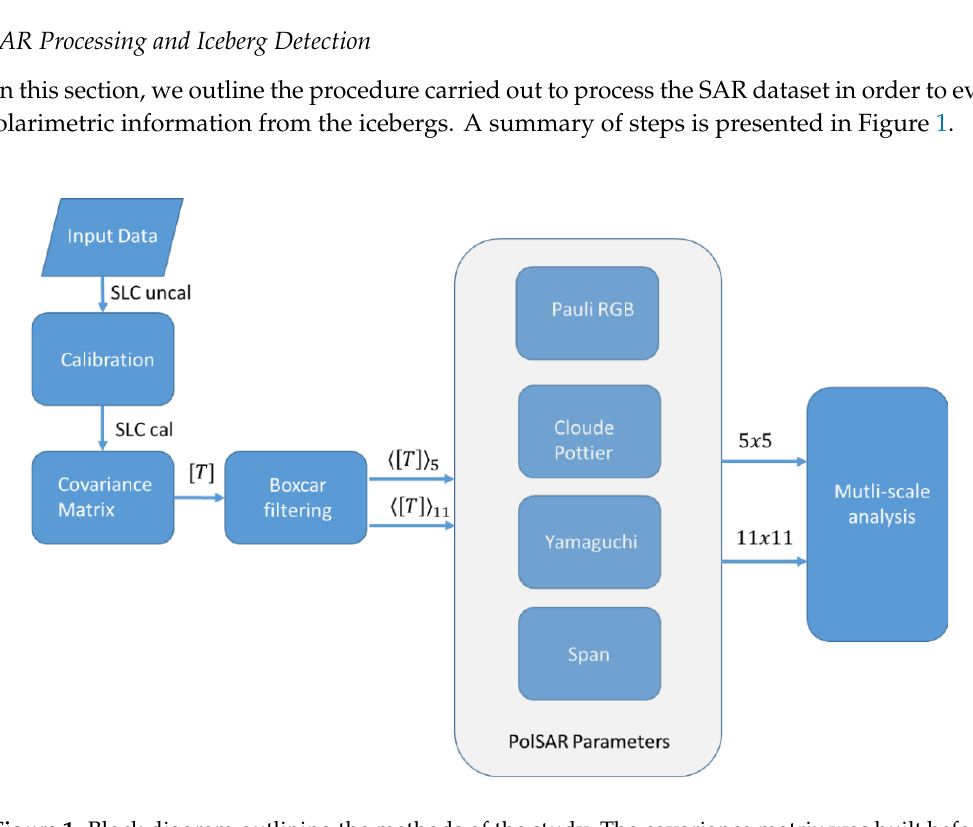
Table 1. ALOS-2/PALSAR-2 JAXA properties. Centre DMS coordinates are selected for latitude and longitude. Incidence angle range is min, centre and max. Note the ground resolution is for ALOS- 2/PALSAR-2 quad-pol mode. Time is UTC.